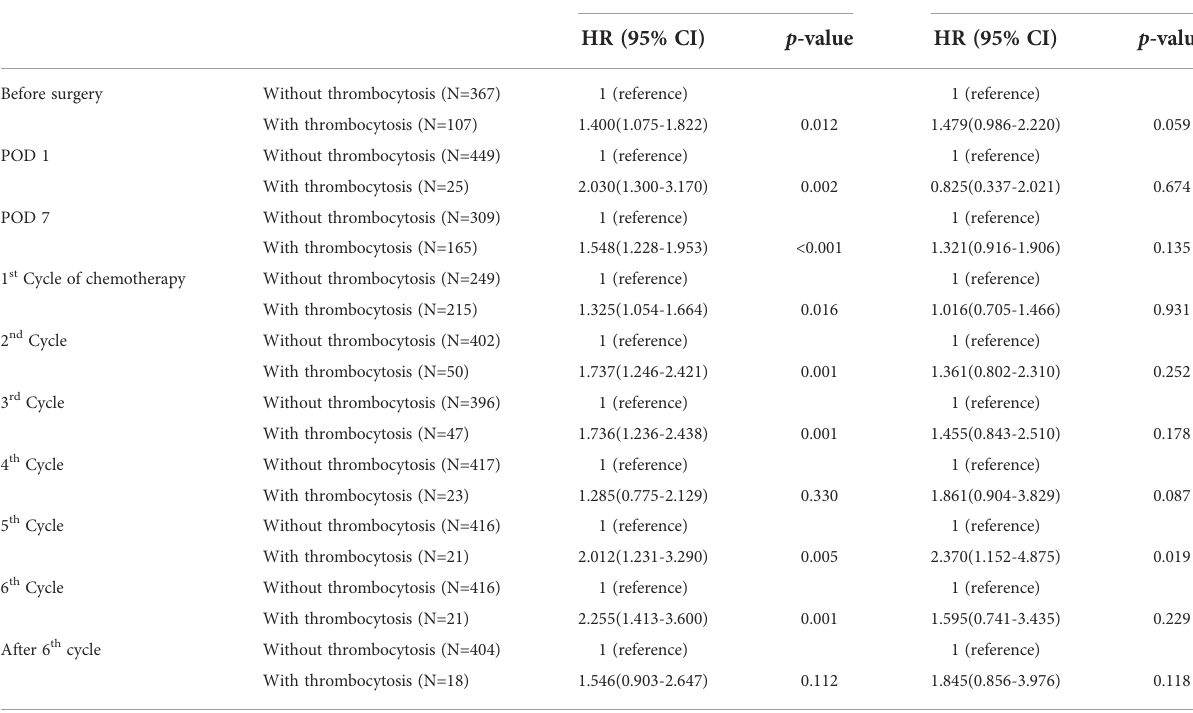
TABLE 2 Univariate analysis: effect of platelet count at each time point on PFS and